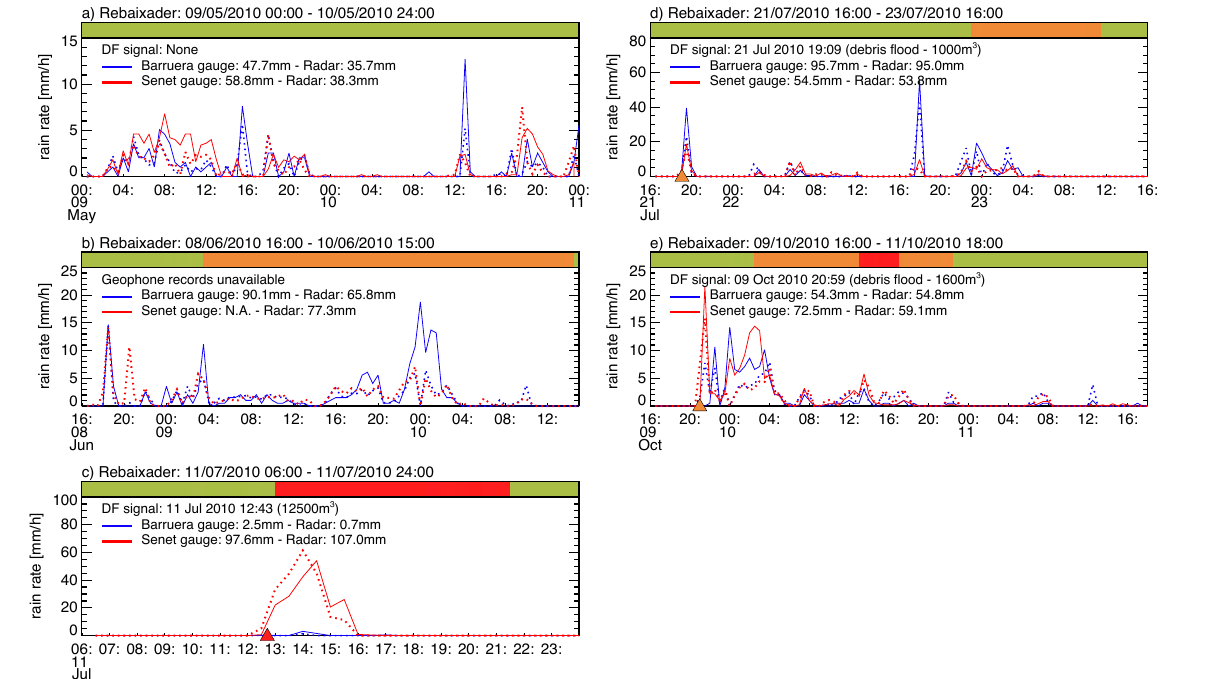
Figure 13. Time series of 30min rain rate observed with the Barruera and Senet rain gauges (blue and red solid lines, respectively) during five rainfall events in the Rebaixader catchment. The two dashed lines correspond to the radar QPE collocated with the two rain gauges. The top color bar shows the time series of the warning level obtained in the Rebaixader subbasin: green, orange and red correspond, respectively, to DF warning level “low”, “moderate” and “high”. The orange and red triangles on the x axis indicate, respectively, the beginning of debris flood and debris flood events detected from geophone records (the text indicates the exact timing and the estimated sediment volume).